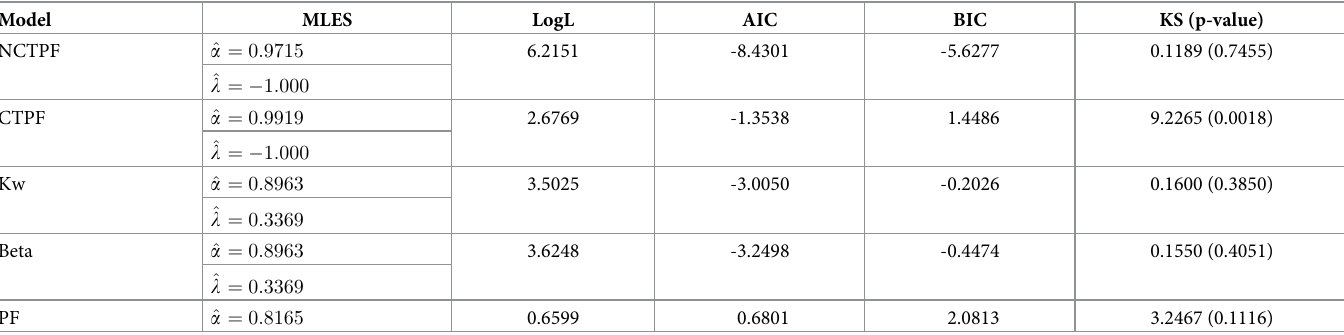
Table 8. ML estimates, AIC, BIC statistics under-considered distributions based on data set. Model